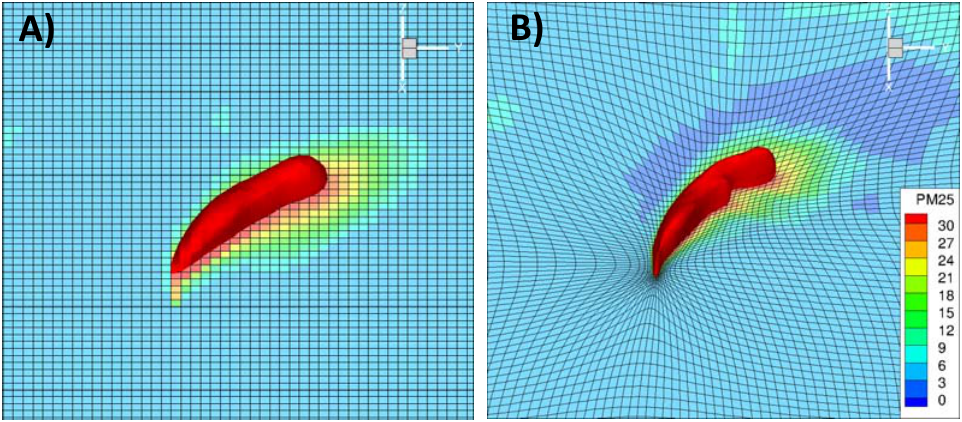
Figure 19. Three–dimensional views of PM 19:15 GMT using ( A ) CMAQ; and ( B )